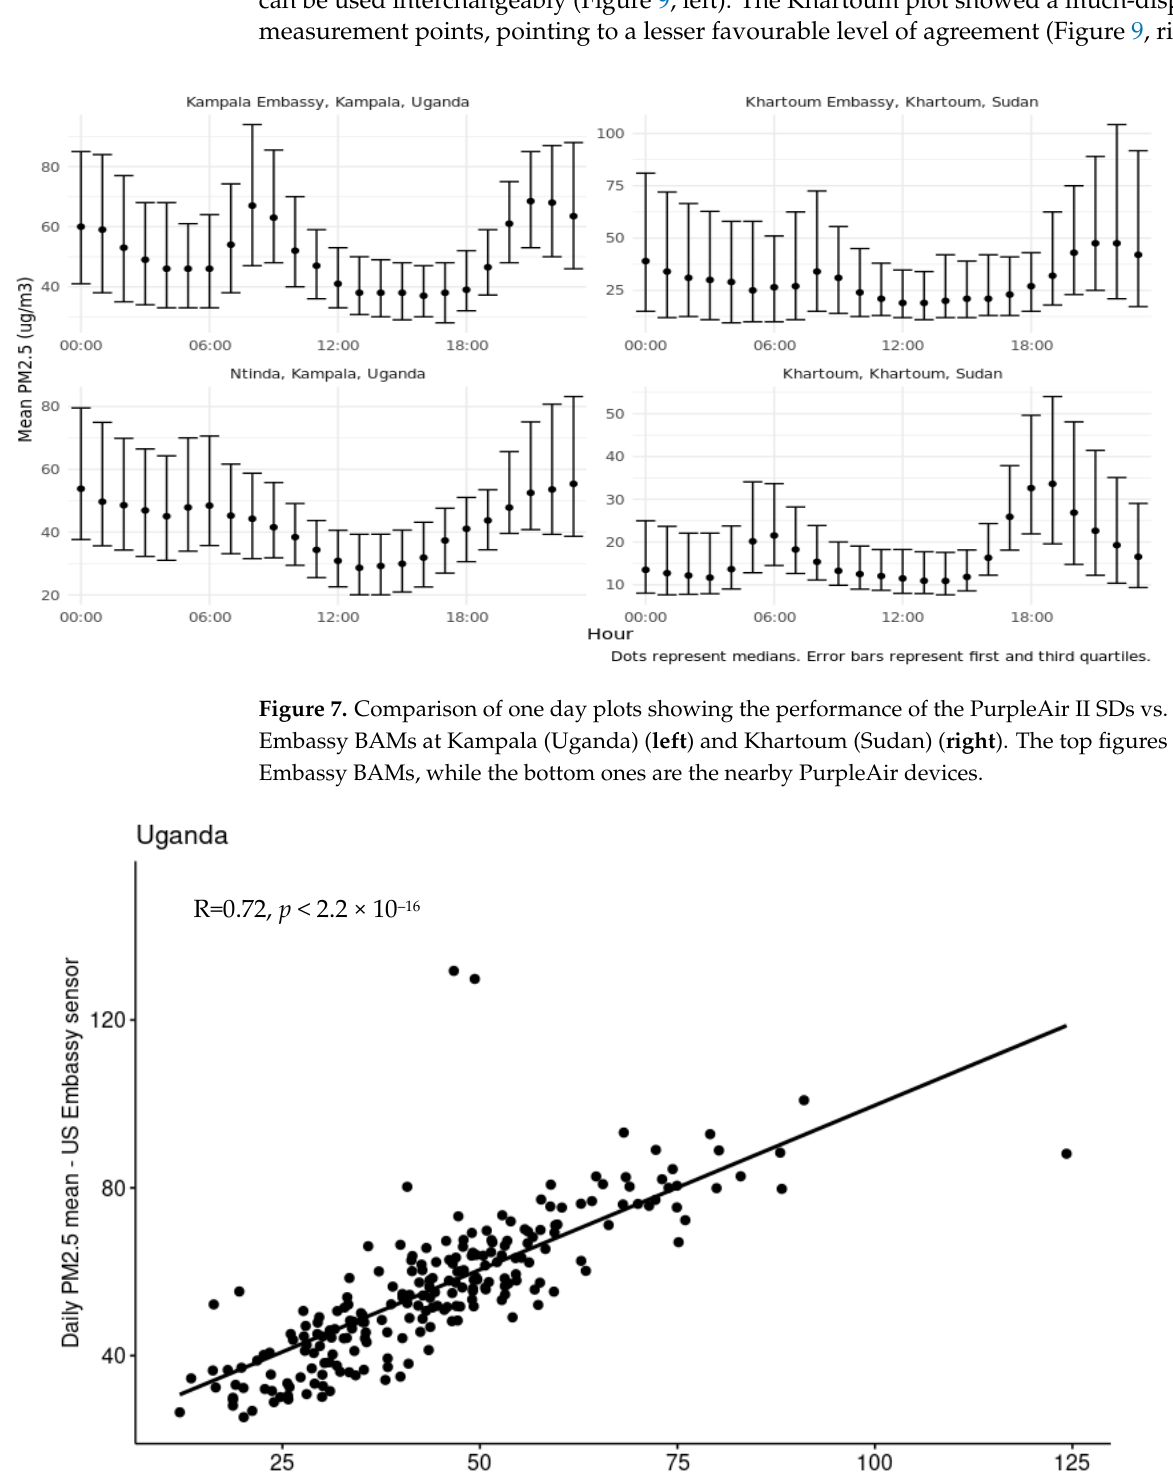
Figure 8. Correlation between the daily mean outputs of the US Embassy BAM and the Purple Air device in Kampala, Uganda.